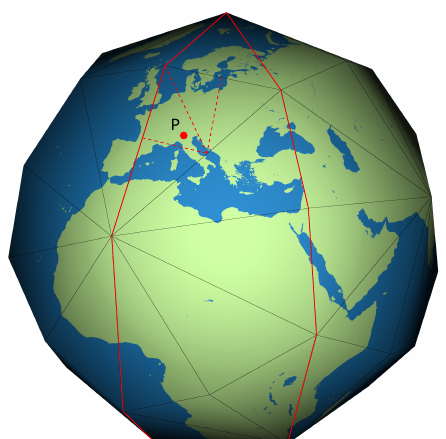
Figure 14. A DT with great circle arcs (longitude) between the North and South pole highlighted in red. The region between these arcs contains 12 base triangles. A point P on the Earth can be quickly checked to see if it lies within the partition created by the red arcs by simply checking its longitude. The dashed lines represent the next subdivision level. The barycentric coordinates of the point within the base triangle determines which child cell P lies